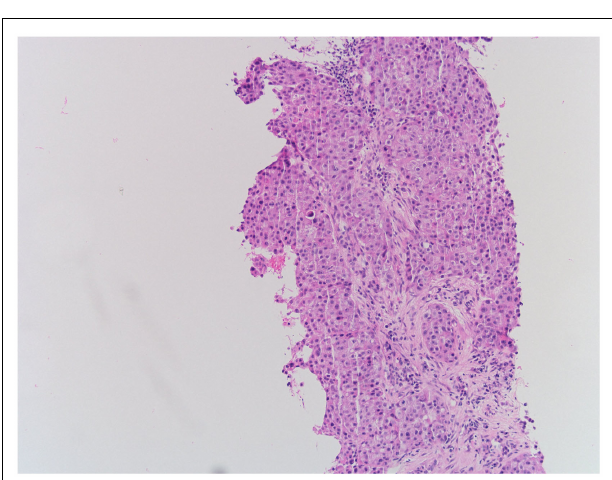
FIGURE 2 | Hematoxylin-eosin staining of left supraclavicular lymph node demonstrating recurrent NSCLC .